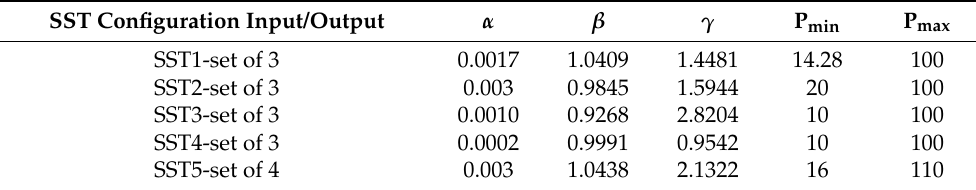
Table 1. SST equation parameters.